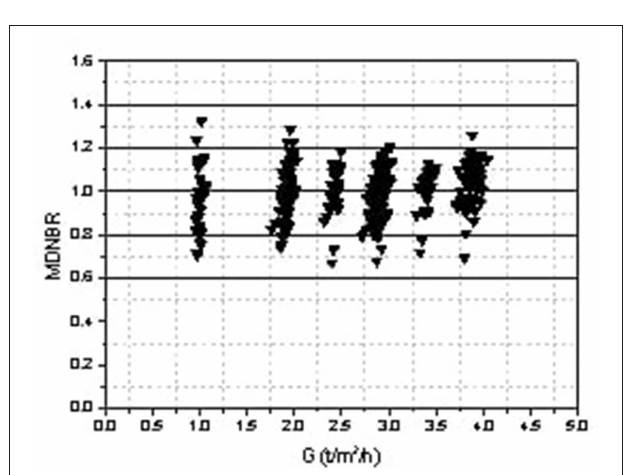
FIGURE 8 | Variation of predicted MDNBRs with mass flux.